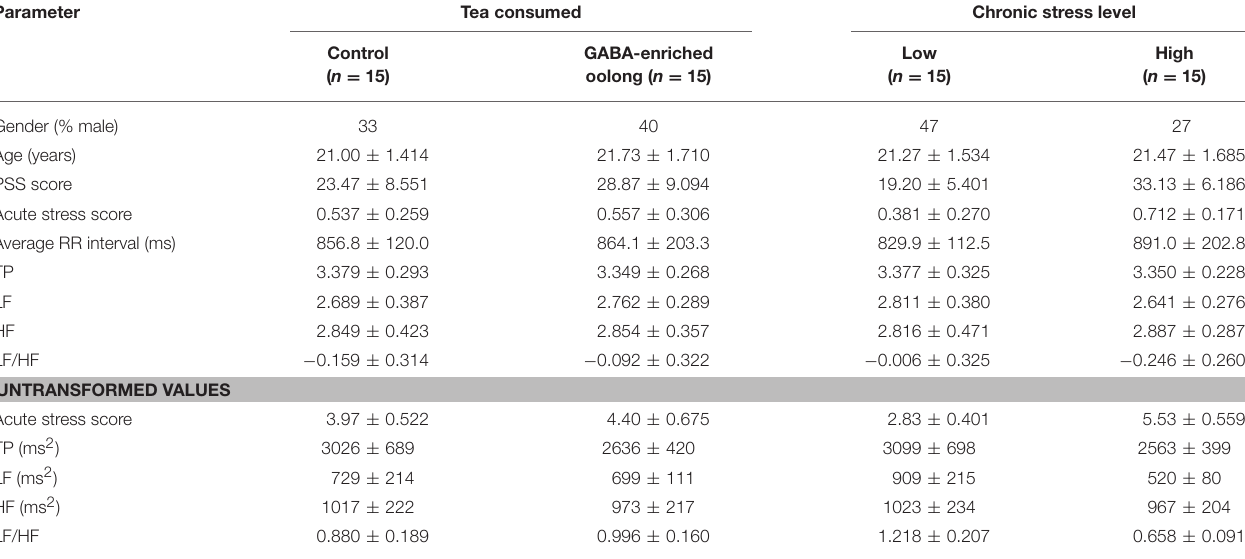
TABLE 2 | Sample characteristics at baseline as divided by tea consumed or chronic stress level.